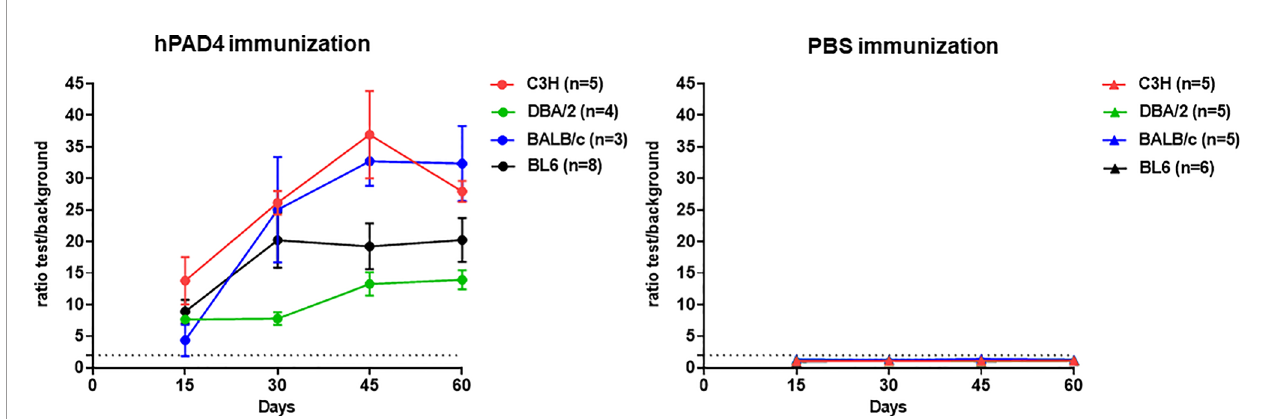
FIGURE 1 | IgG response to hPAD4. Anti-hPAD4 IgG was evaluated by ELISA using sera obtained at 15, 30, 45 and 60 days post fi rst immunization. Background OD was obtained by adding each serum to a well without protein. Sera were evaluated by measuring the ratio test OD/background OD. Ratios equal or higher than 2 de fi ned positive sera. Means +/- SEM were calculated for each group of